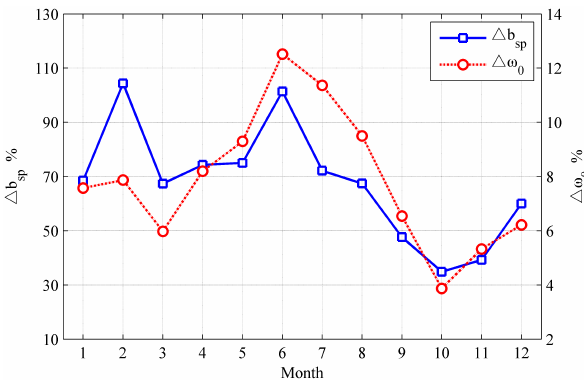
Figure 7 Contribution of RH to b sp and ω 0 enhancement Figure 7. Contribution of RH to b sp and ω 0